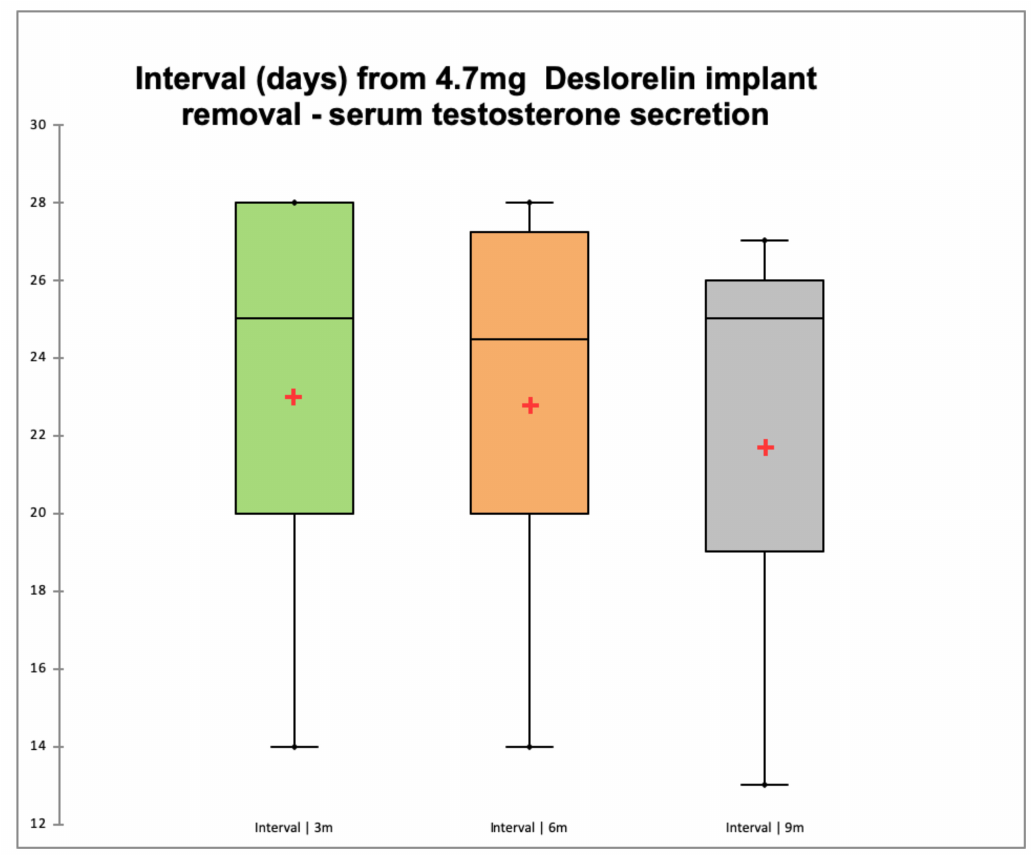
Figure 2. Interval between removal of a 4.7 mg deslorelin implant and restoration of testosterone secretion ( ≥ 1.0 ng / mL) in adult tomcats treated for 3 (green), 6 (orange), and 9 months (grey) of 5 and 4 cats treated, respectively. The interval for the three groups of cats was 23 ± 6, 23 ± 6, and 22 ± 7 days, respectively, and did not di ff er among groups ( p > 0.05). The red cross indicates the mean value while the black bar above the cross indicates the median value